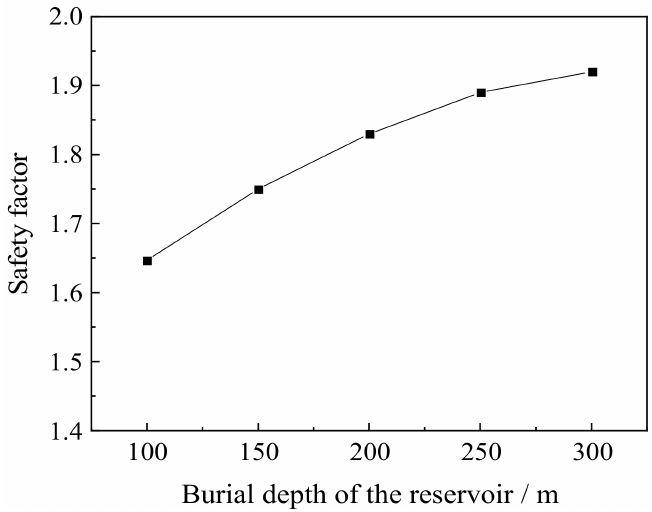
Figure 8. Safety factors corresponding to different burial depths of the reservoir.